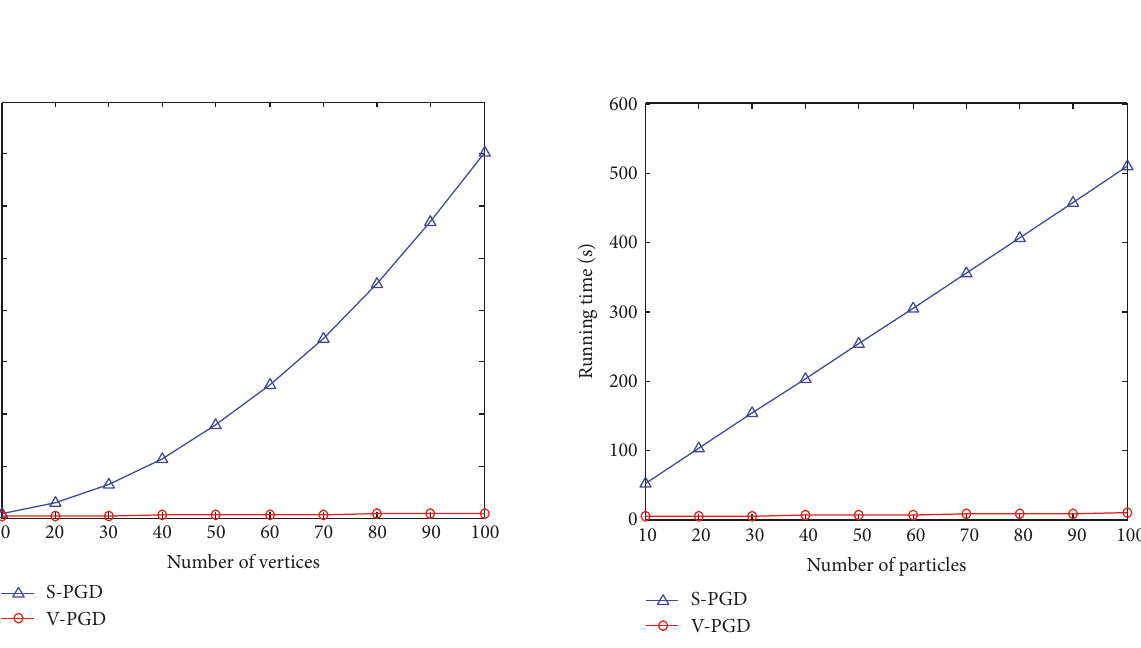
Figure 9: Drawings of 10 random graphs in Group 2.